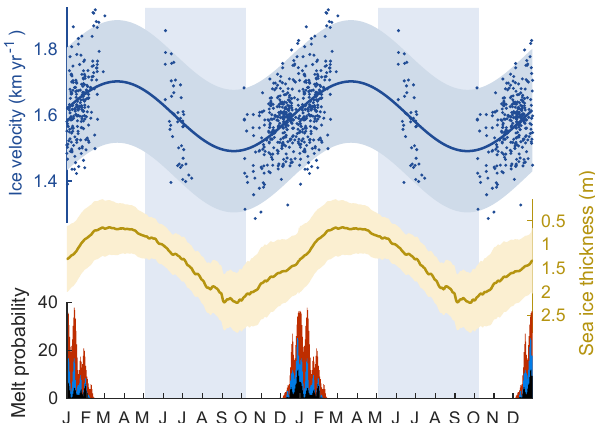
Figure 7. Causes of springtime acceleration. Time series of MODIS-derived ice velocity ± 2 σ shaded, ECCO v4-r3 sea ice thickness ± 2 σ shaded, and melt probability repeated from Figs. 3, 4, and 6. Note the inverted axis of the sea ice thickness time se- ries. Characteristic springtime acceleration near the TIS front be- gins with the breakup of landfast sea ice and is possibly enhanced later in the year by shear margin weakening resulting from surface melt. Vertical shaded blue areas indicate typical times of landfast ice connection with TIS. Two years of the mean cycle are shown for visual continuity. Velocity anomalies predicted from basal melt are not shown here because the ± 1myr − 1 amplitude would visually indiscernible at the observed scale of interannual velocity variabil-